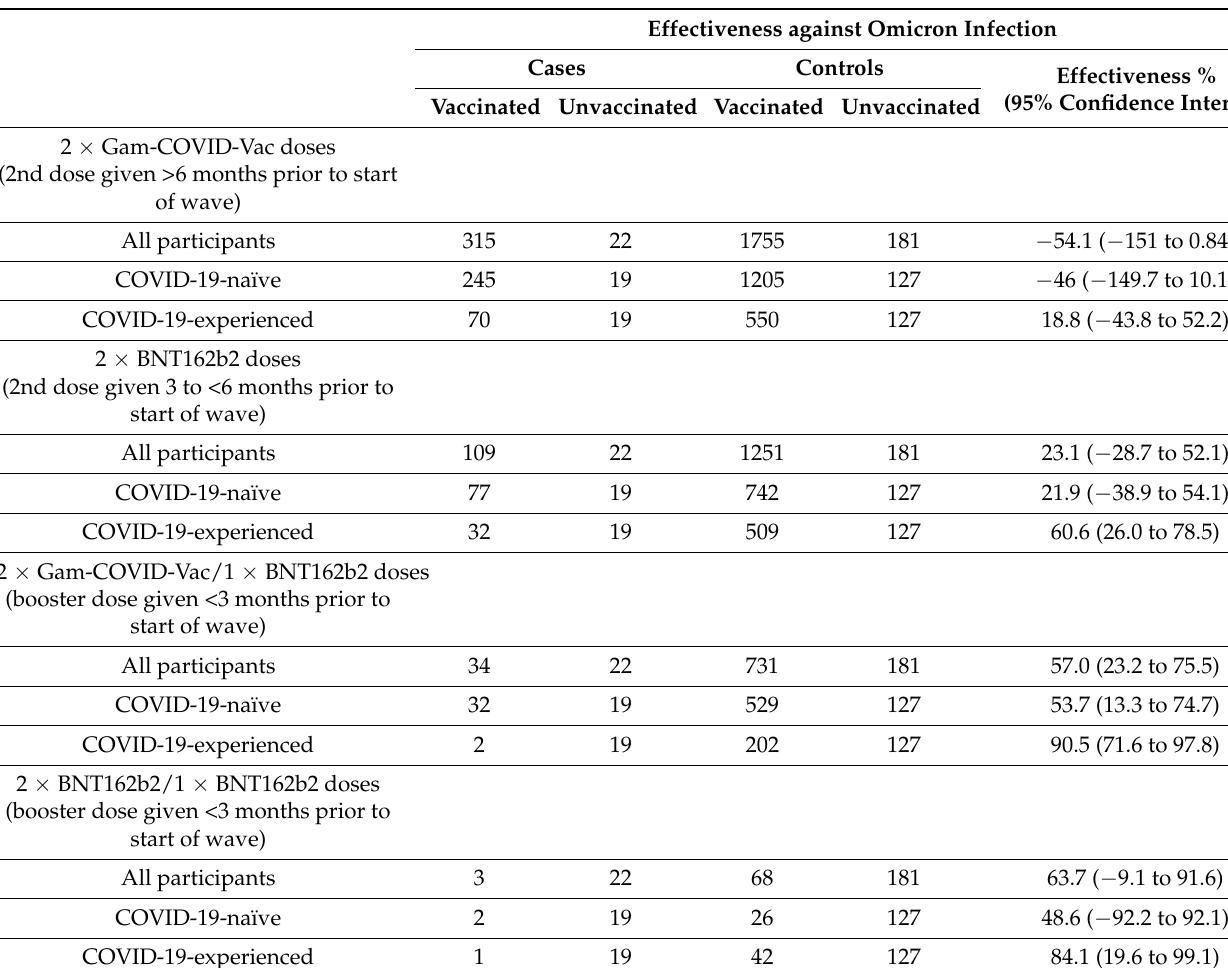
Table 2. Effectiveness of the available COVID-19 vaccination schemes during the Omicron